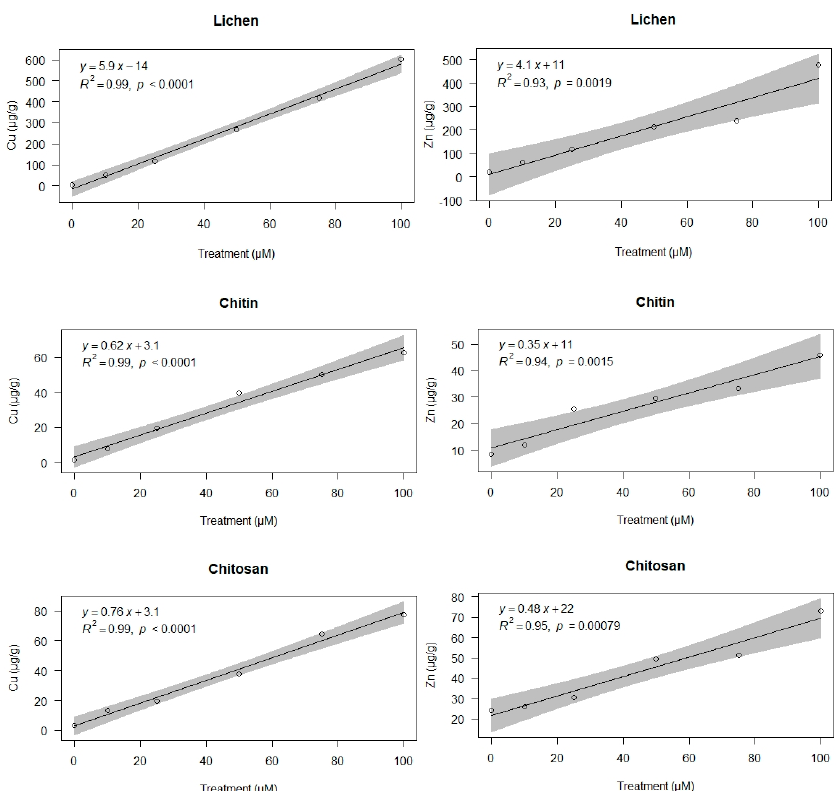
Figure 1. Copper and zinc concentrations (µg/g) in lichen, chitin, and chitosan samples after incubation with Cu ( left ) and Zn ( right ) solutions at the concentration 0 (control), 10, 25, 50, 75, and 100 µM. The grey area indicates the IC95 confidence interval.